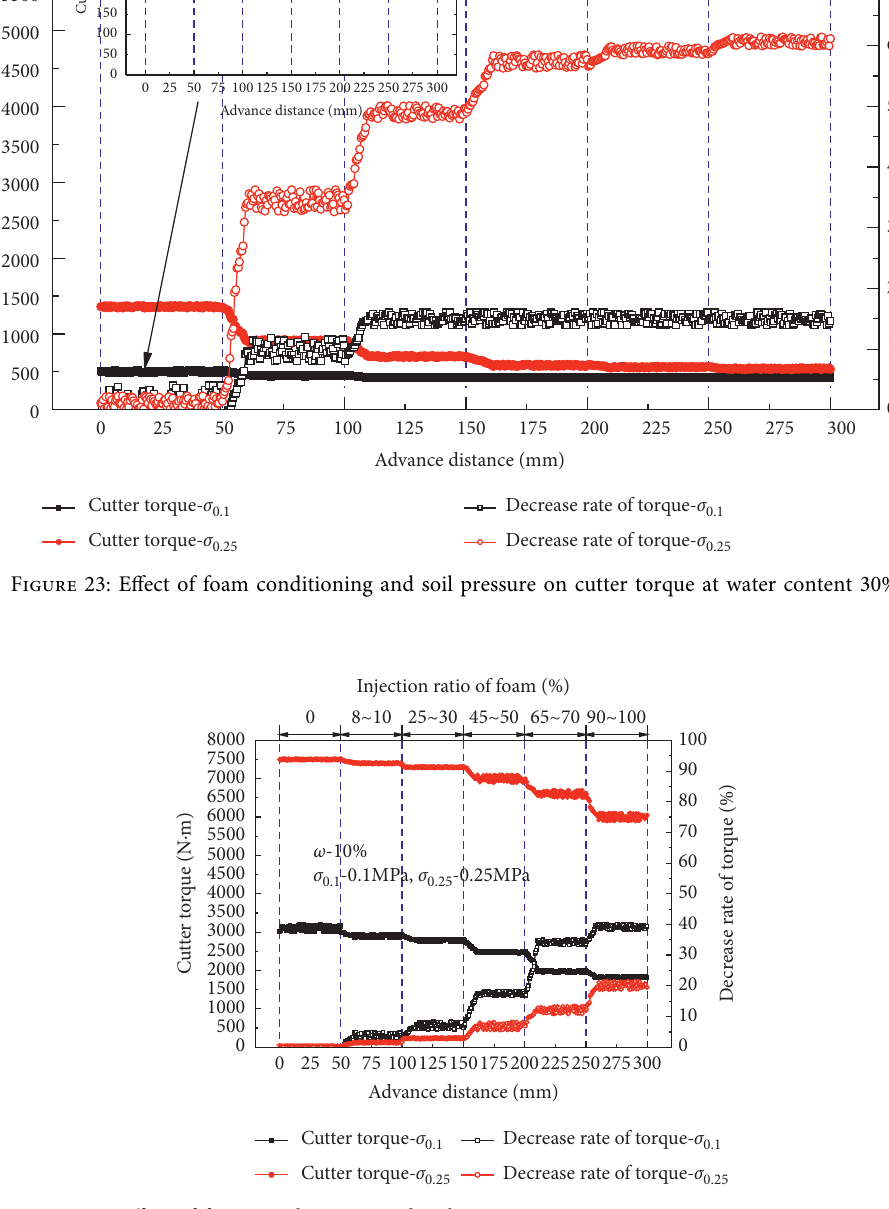
Figure 24: Effect of foam conditioning and soil pressure on cutter torque at water content 10%.